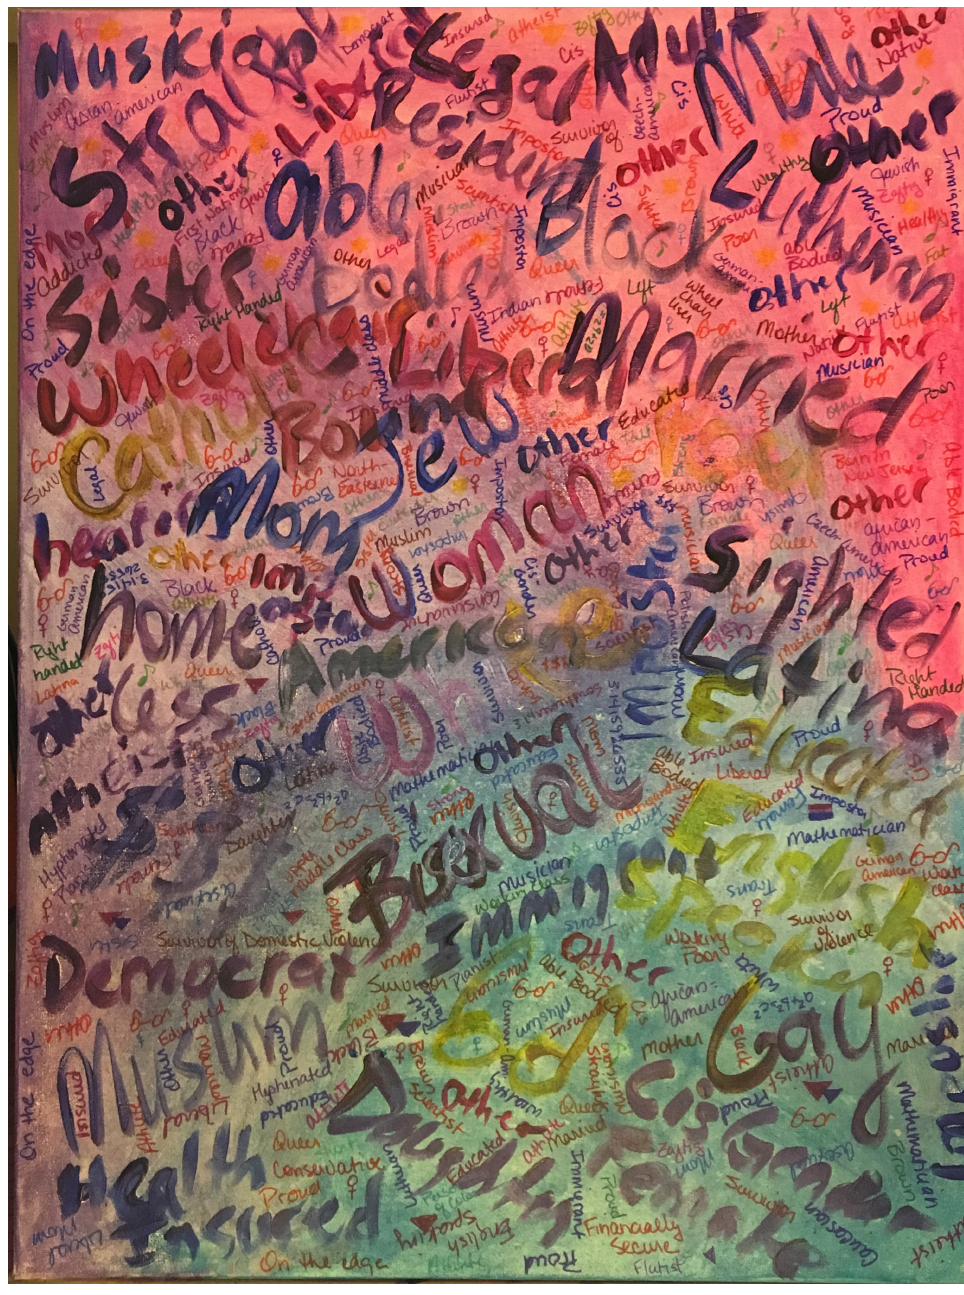
FFigigururee 2.2. “Be“Beyyondond